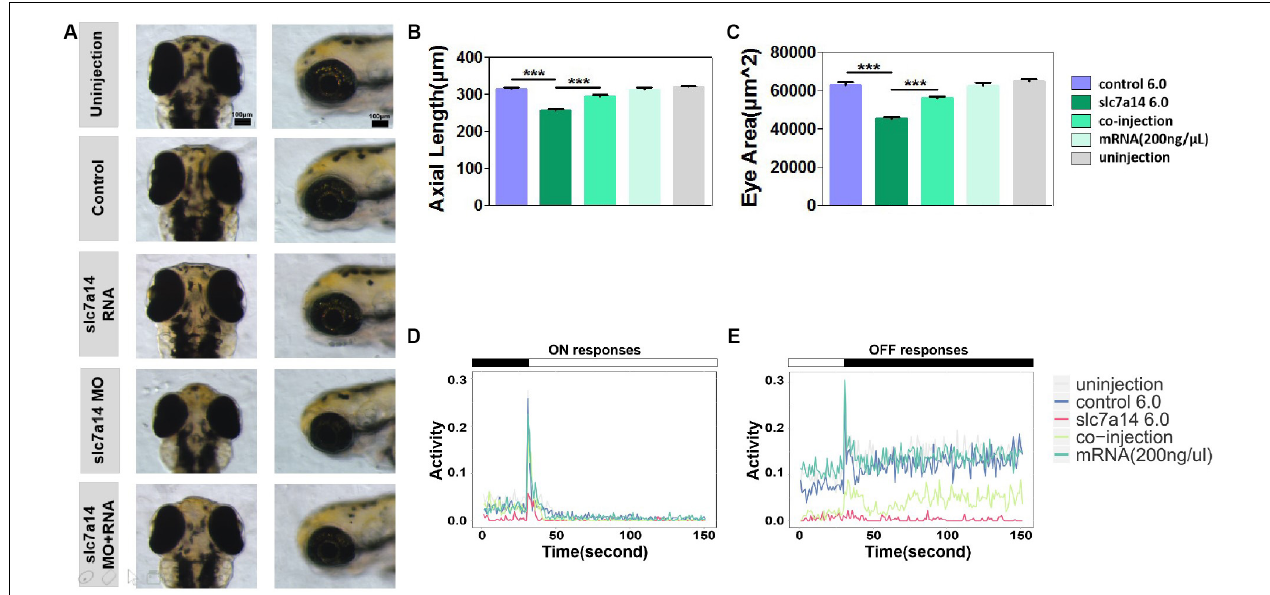
FIGURE 6 | Slc7a14 mRNA compensation rescued the phenotypes in slc7a14 -deficient morphants. (A) Magnified vertical and lateral views of larval eyeballs. Larvae injected with slc7a14 MO and full-length slc7a14 mRNA showed normal-sized eyeballs at 3 dpf. Scale bar = 100 µ m. (B,C) Statistical results for the axial length and ocular area. N = 30 in each group. (D,E) VMR testing showed dramatic recovery of both the ON and OFF responses in slc7a14 -deficient zebrafish compensated with mRNA compared to slc7a14 -deficient zebrafish without compensation. N = 12 in each group. Rescue experiments were repeated three times. Bar plots are shown as the mean ± s.e.m. Data was analyzed using One-way ANOVA followed by Tukey’s post hoc test, ∗∗∗ P < 0.001 significantly different from slc7a14 6.0 ng